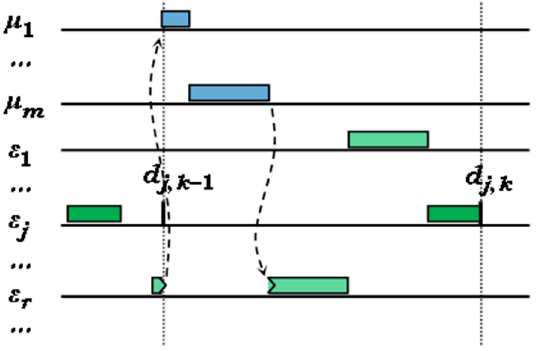
Figure 3. Higher priority MEDF task blocked by a lower priority one, previously interrupted by the FENP context.